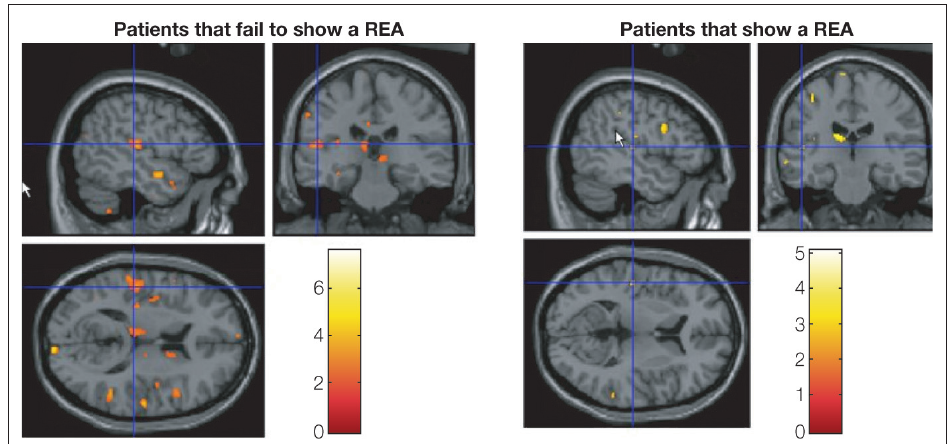
Figure 5 | VBM results showing significant reduction of grey matter concentration in patients who fail to show a REA in the dichotic listening test in the left temporal lobe, thalamus, and in adjacent to the ventricles. The patient group was split, on the median laterality index score, into sub-group showing a REA and sub-group not showing a REA. The colors indicate significant reduction in grey matter density in the patients not showing a REA. Data are redrawn from Neckelmann et al.